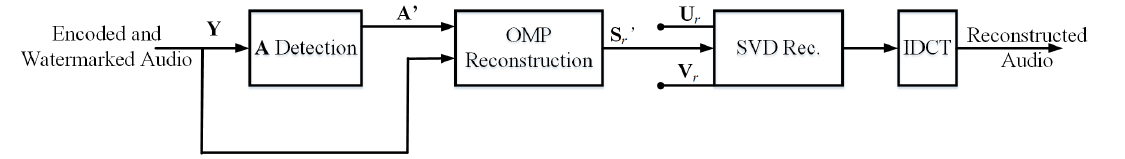
Figure 2. Watermark detection and audio decoding. Table 3. Detection and reconstruction